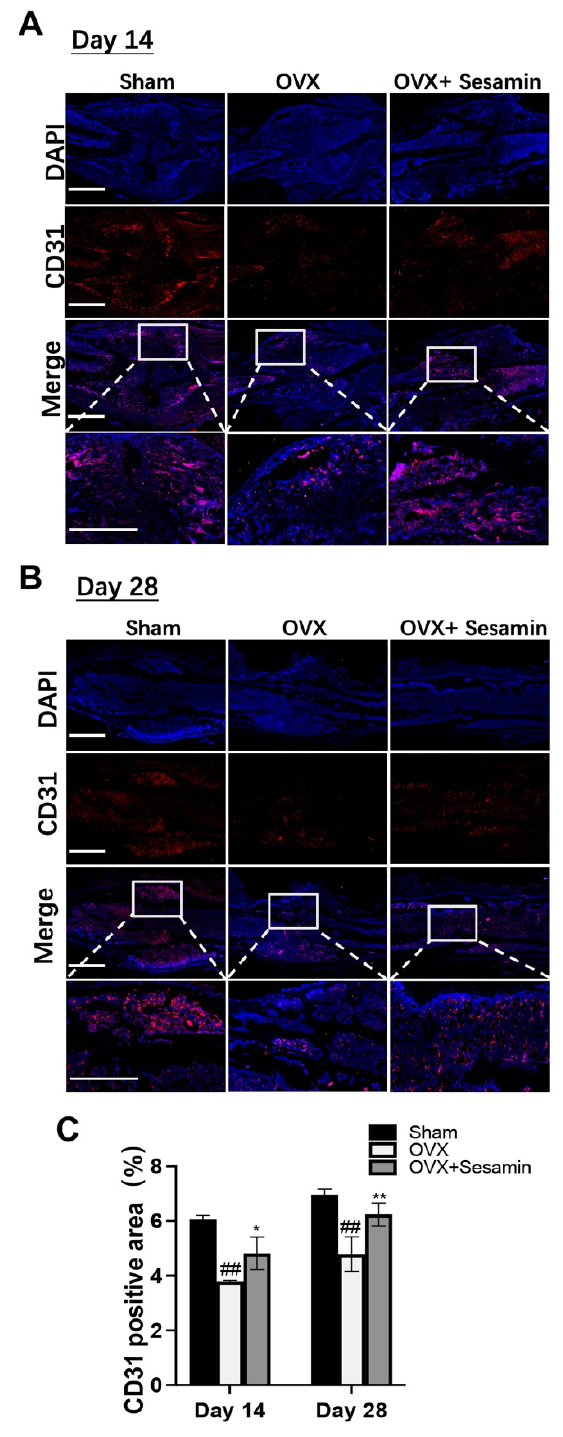
Figure 6. Sesamin promoted angiogenesis within callus area in vivo: ( A , B ) The IF staining of CD31 positive area in each group 14 ( A ) or 28 days ( B ) after fracture. ( C ) Semi-quantitative analysis of CD31 positive area ( n = 6; ## p < 0.01 vs. Sham group; * p < 0.05, ** p < 0.01 vs. OVX